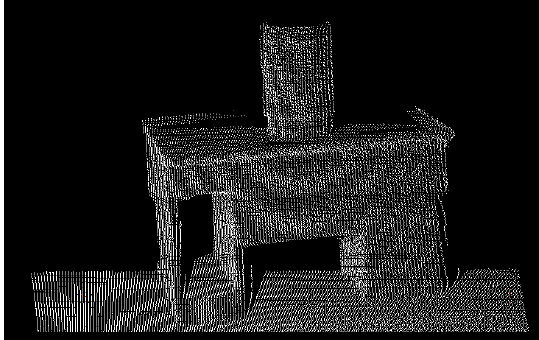
Figure 9. 3D point cloud of measured cylinder.